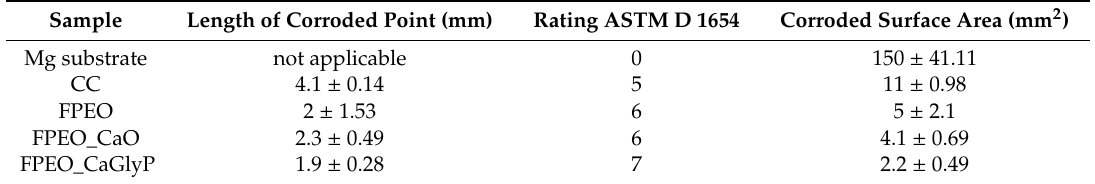
Figure 11. Macrographs of the scribed area of the painted specimens before (“Fresh”) and after 7 days of NSST, showing the creepage extent. Table 9. Creepage evaluation and the ASTM D 1654 rating of the painted materials following 7 days of exposure to neutral salt spray